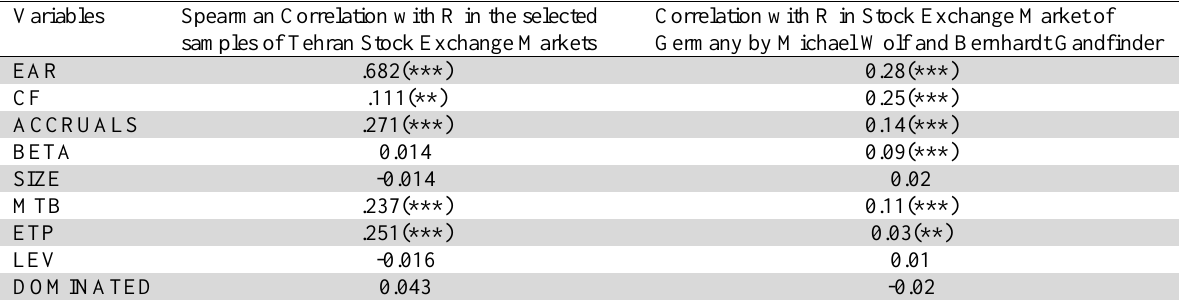
Comparison between the effects of main variables Variables